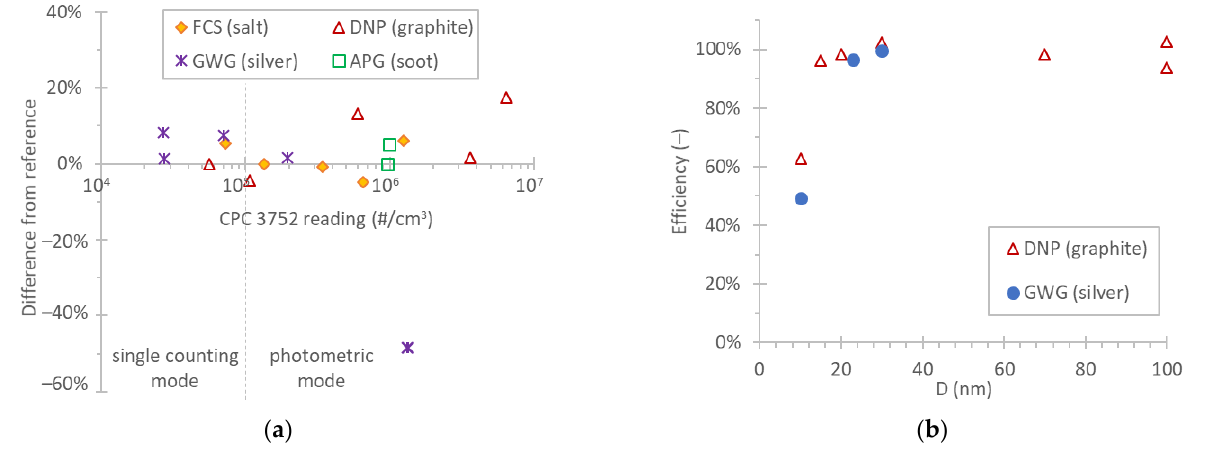
Figure 2. Control of reference instruments: ( a ) CPC 3752 photometric mode and single-counting mode with various materials with sizes 10 – 15 nm for silver, 30 nm for soot and graphite, and 60 nm for salt; ( b ) efficiency of CPC 3010 vs. CPC 3752 with various materials having applied the calibration factors: 6% at CPC 3752 and 10% at CPC 3010.